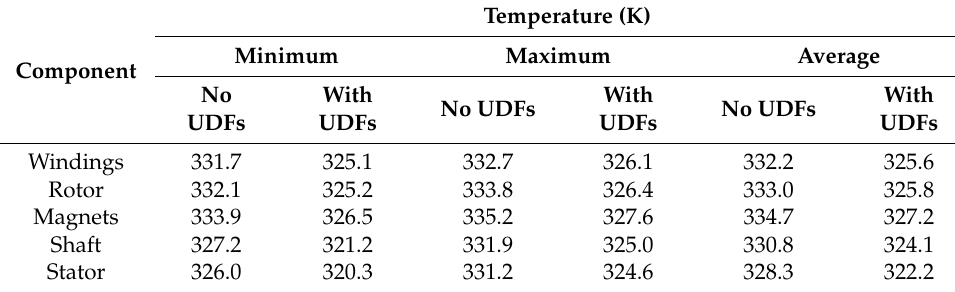
Table 1. Thermal analysis with and without viscous loss and viscosity UDFs.